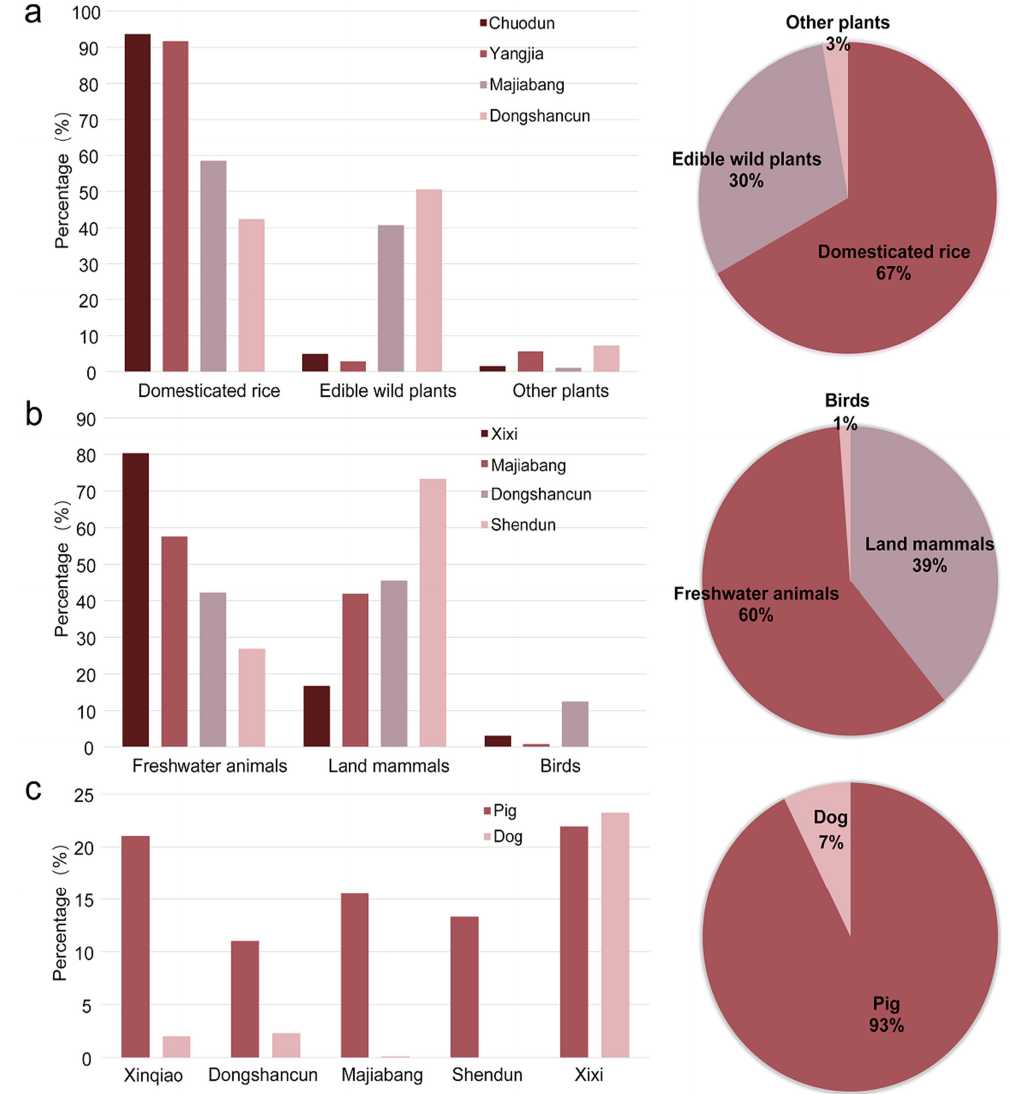
Figure 3. Comparison of different food resources during the Majiabang Cultural period. Percentages ( left ) and relative proportions ( right ) of the three plant groups from the four sites ( a ); percentages ( left ) and relative proportions ( right ) derived from the NISP data of the three animal groups from the four sites ( b ); percentages of pig and dog among mammals ( left ) and relative proportions ( right ) of pig and dog from the five sites ( c ). Note: one rice spikelet base was equal to one rice grain in the statistical analysis, and the same hereinafter.